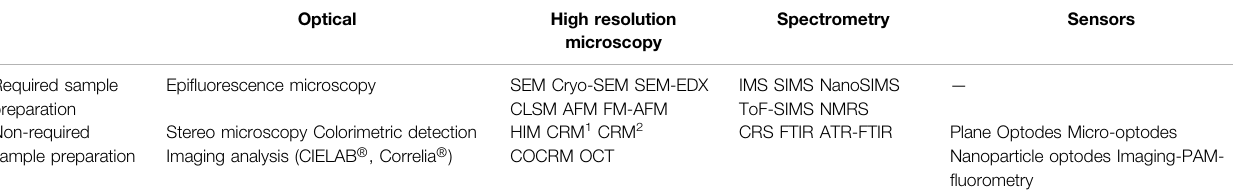
TABLE 3 | Non-destructive imaging techniques of architectural features for bio fi lm